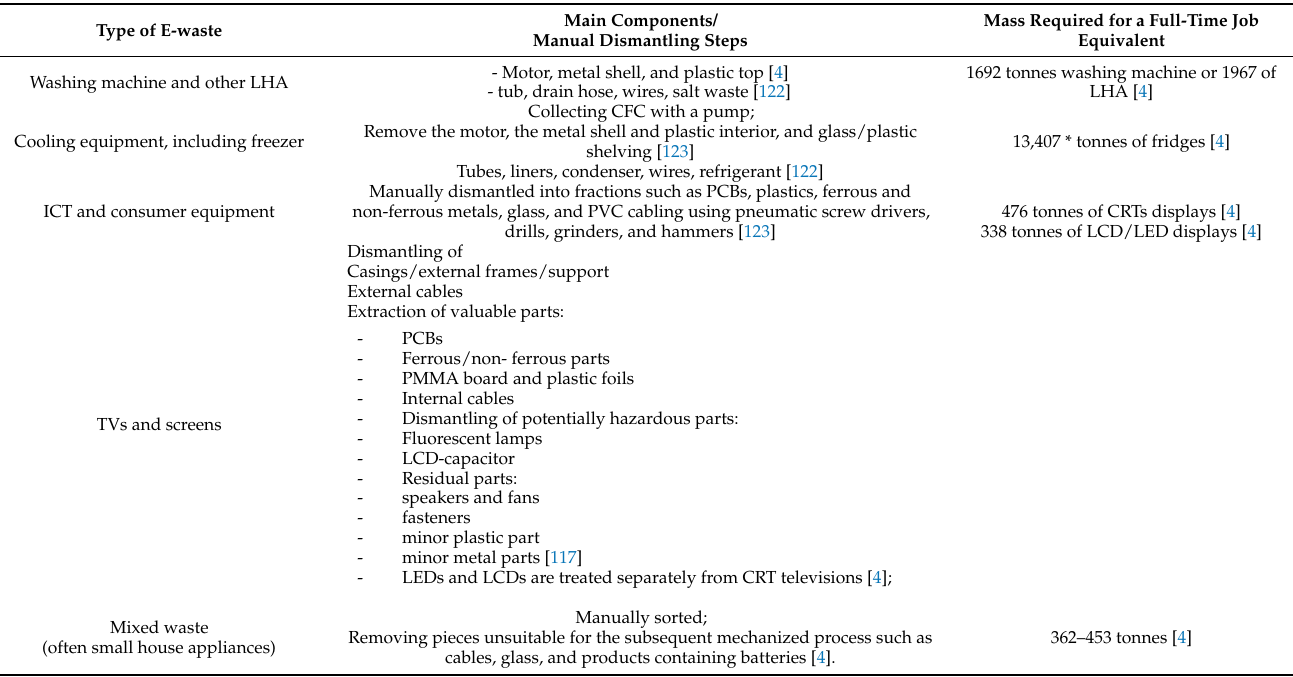
Table 9. Summary about manual dismantling, main components of some e-waste, and mass required for a full-time job